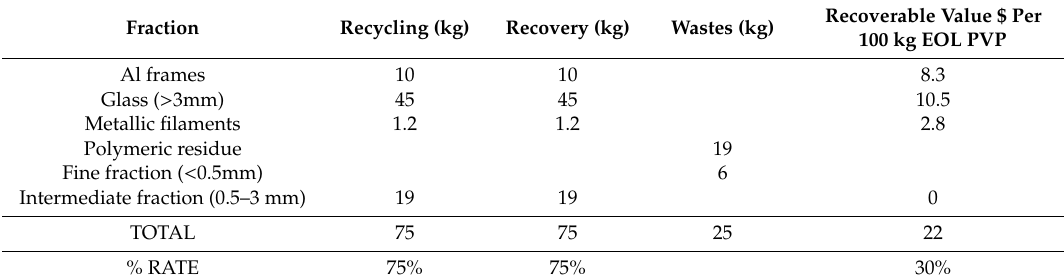
Table 2. Recycling rate, recovery rate, amount of wastes produced, and recoverable value according to mass balances for the PhotoLife process considering 100 kg EOL PVP as process